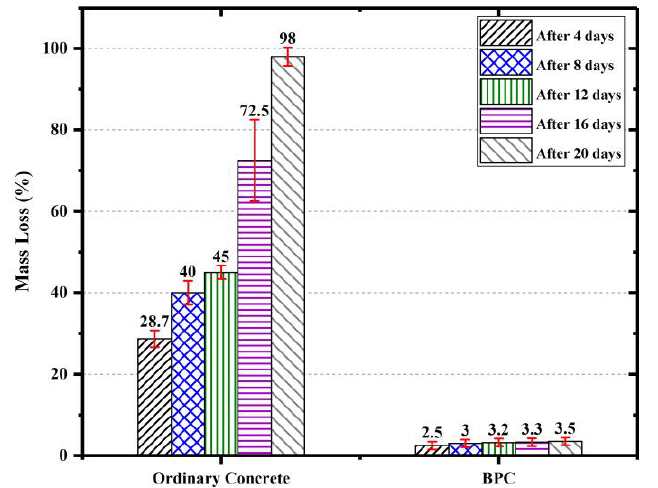
Figure 8. Weight loss of ordinary and BPC exposed to hydrochloric acid (HCL). Values shown above the bars represent the mean values.